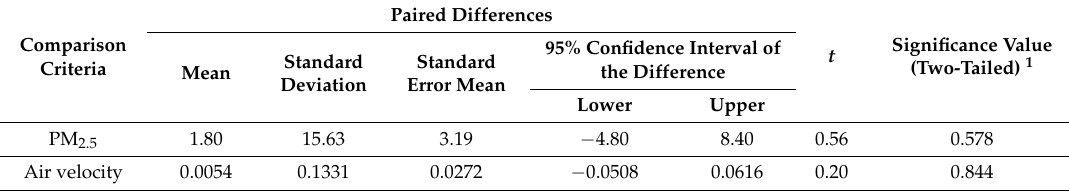
Table 2. Paired sample t -test for the validation criteria comparing the on-site measured and simulation results.